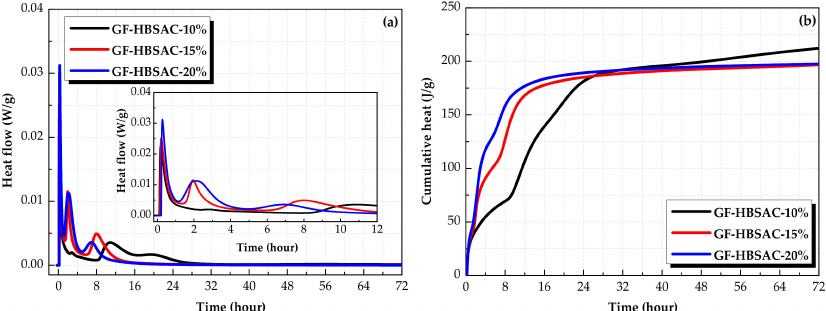
Figure 20. Hydration heat curves of the Series GF-HBSAC-Y cement. ( a ) Heat flow curve; ( b ) cumulative heat